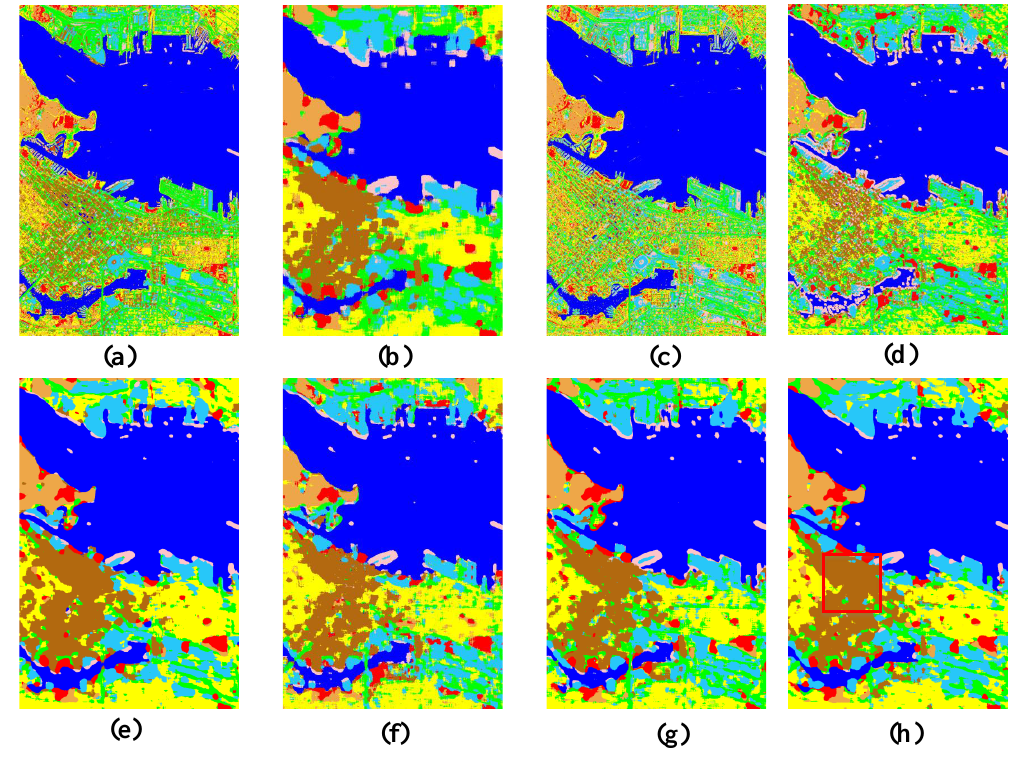
Figure 5. Classification maps with different methods on Level 1C dataset. ( a ) EMAP. ( b ) CAE. ( c ) RNN. ( d )